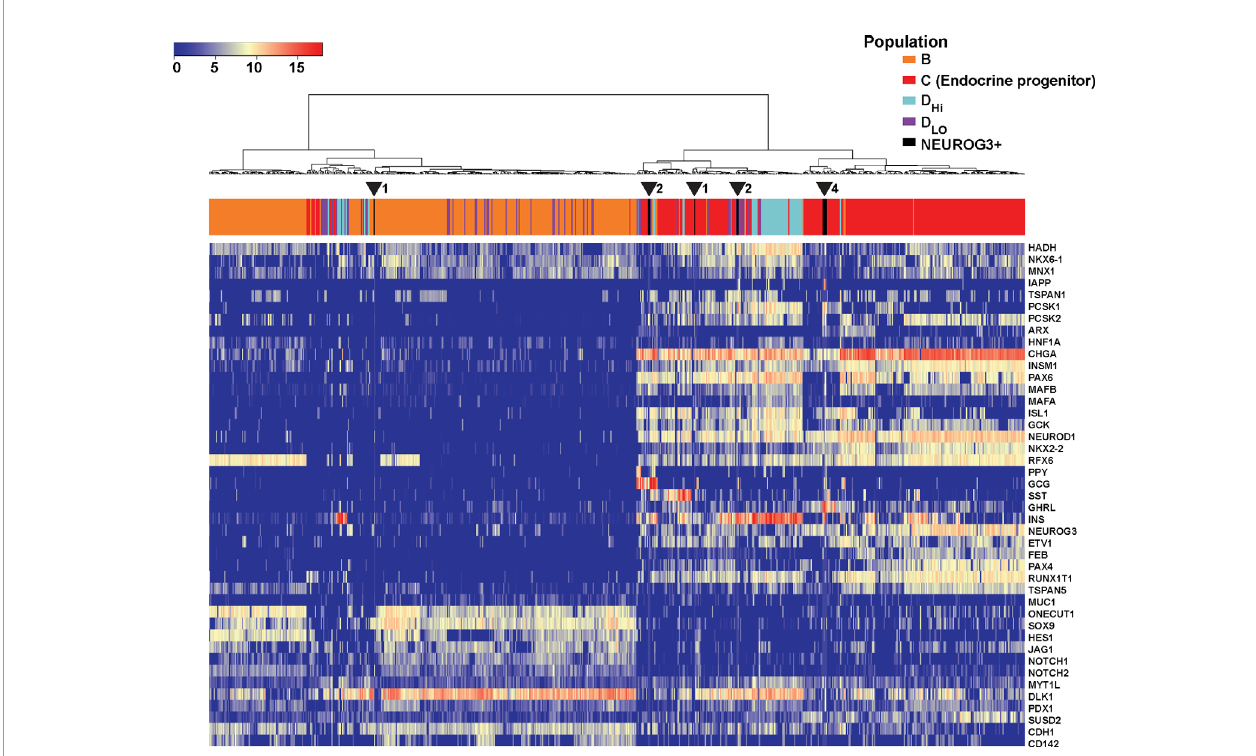
FIGURE 5 | NEUROG3+ cells in the postnatal human pancreas cluster with NEUROG3+ cells from the fetal pancreas. Heatmap displays the relative gene expression of postnatal NEUROG3+ cells and single cells isolated from the human fetal pancreas, along with hierarchical clustering. Dendrograph displays color- coded populations: B (orange), C (red), D Hi (light blue), D lo (violet) and NEUROG3+ cells (black). Population labels are consistent with the original publication (39). Population C is the endocrine progenitor population (EP). Nine out of 10 NEUROG3+ cells cluster with EP. The location of NEUROG3+ cells are indicated by arrowheads, with the number of NEUROG3+ cells in each location denoted next to each